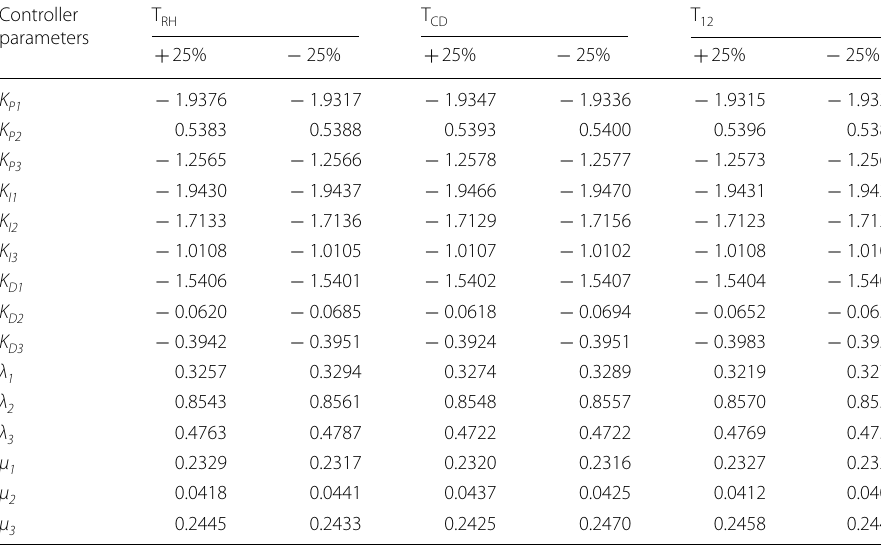
, T and T conditions RH CD 12